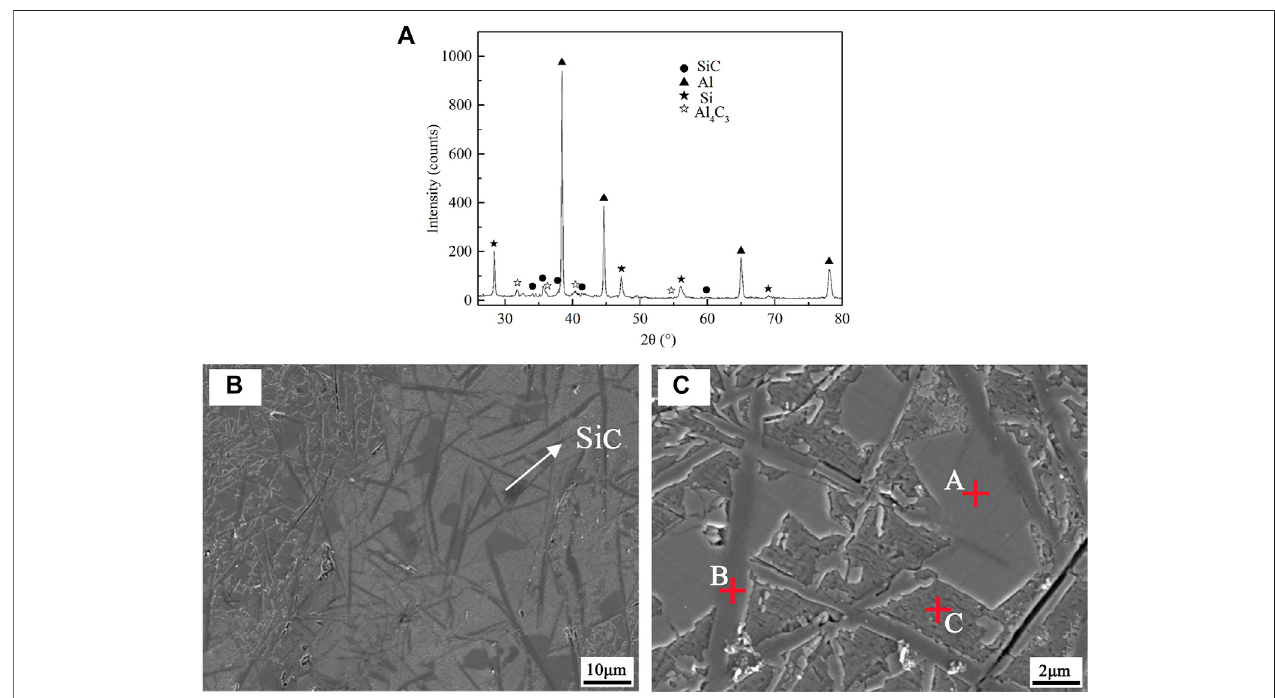
FIGURE6|(A) XRDpatternofweldmetalwithoutTiinterlayer, (B) SEMmicrographoftheregionbetweenweldmetalandheataffectedzone, (C) theenlargedview of the interfacial region in (B) .